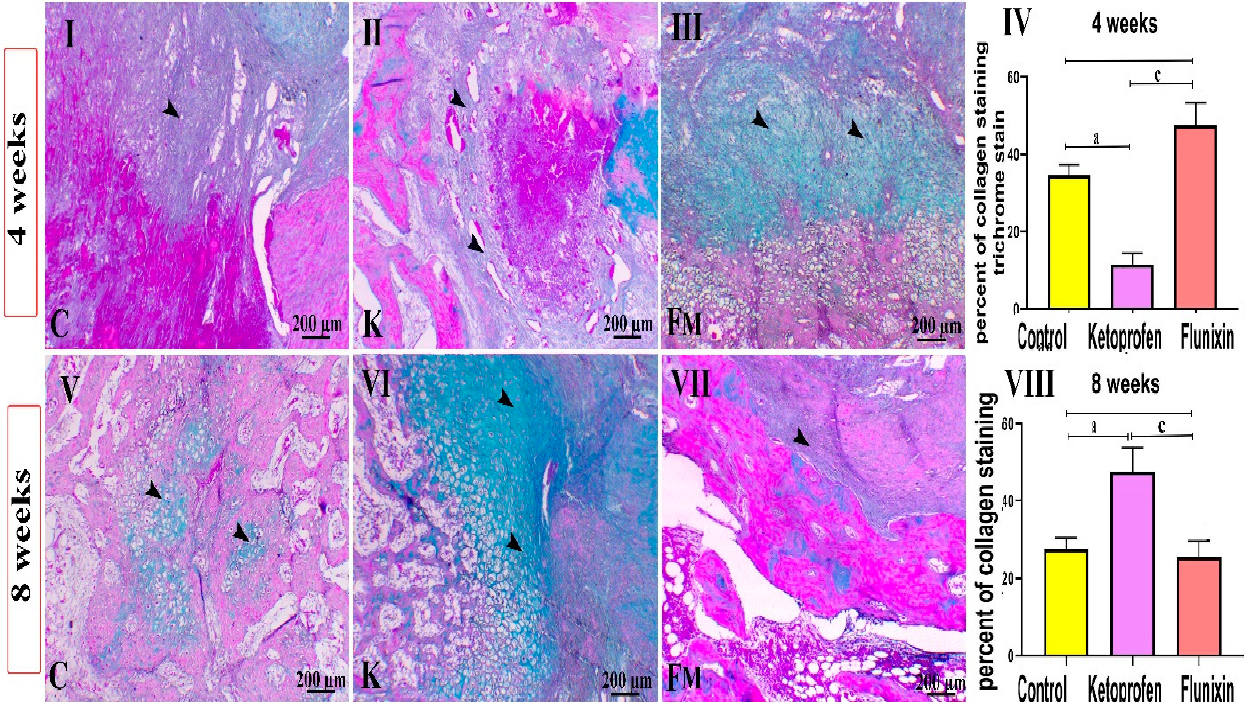
Figure 7. Photomicrographs of different Masson’s trichrome-stained femur sections of different groups (8 weeks). C indicates the control group, K indicates the ketoprofen group, and FM indicates the flunixin meglumine group. FM treated animals showed early fibroblastic activity, whereas the ketoprofen group still demonstrated pronounced fibrosis in the 8th week. Masson’s trichrome stain. Data are expressed as mean ± SD. Superscript letters indicate the significance level; a denotes the significant difference between the ketoprofen and the control groups; c: denotes the significant difference between the FM and the ketoprofen groups. ( p < 0.05). ( I , V ) denote control group at 4, and 8 weeks. ( II , VI ) denote control group at 4, and 8 weeks. ( III , VII ) denote control group at 4, and 8 weeks. ( IV ) denotes statistical graph to the percent of trichrome staining at 4 weeks between control, ketoprofen, and FM groups. ( VIII ) denotes statistical graph to the percent of trichrome staining at 8 weeks between control, ketoprofen, and FM groups.